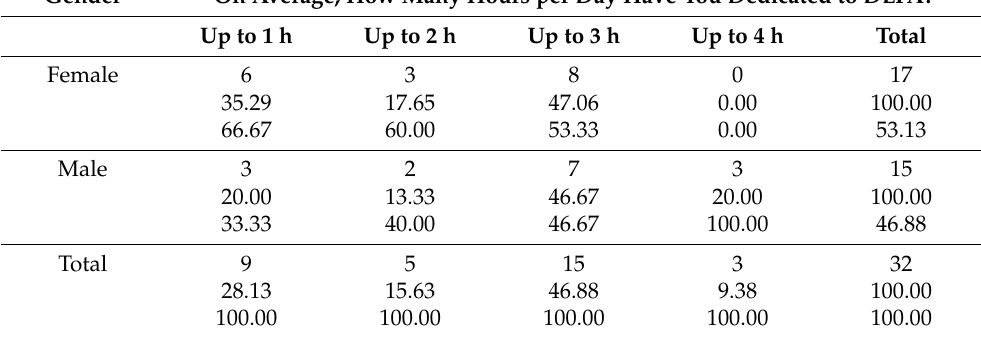
Table 5. Analysis of gender by average hours per day dedicated to distance learning of financial accounting